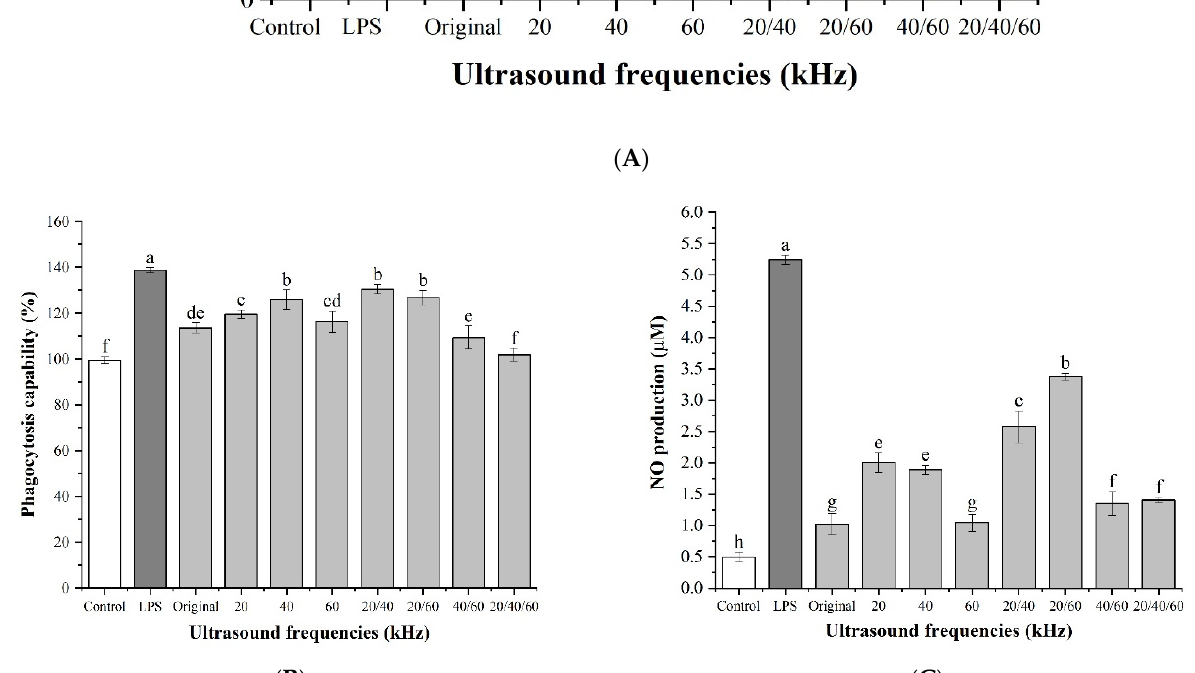
Figure 5. Immunomodulatory activities: effect of lentinan on cell viability ( A ); phagocytic activities ( B ); NO production ( C ). * Significant correlation at the 0.05 level. ** Significant correlation at the 0.01 level. NO production ( C ). ** Significant correlation at the 0.01 level. Different letters in the figure indicate significant differences ( p <